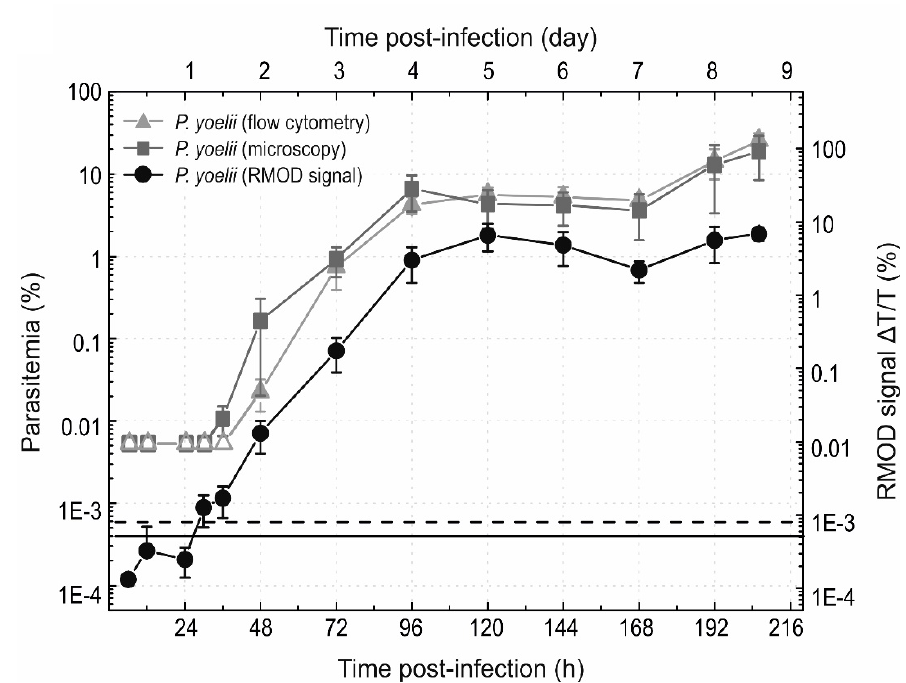
Figure 2. Progression of the blood-stage infection in mice injected with P. yoelii parasitized RBCs. The triangles represent parasitemia values measured by GFP-based flow cytometric detection; the squares represent parasitemia values determined by microscopy and the circles display the RMOD signal. The empty squares and triangles show samples declared negative either by microscopy after counting 10,000 red blood cells, or by flow cytometry. Each symbol and error bar represents the average and standard deviation of values measured on blood samples from n = 4 mice. The continuous black line represents the average of the RMOD values of ~20 uninfected control samples. The dashed black lines indicate the detection limit of RMOD defined as the average plus two times the standard deviation of the uninfected values.